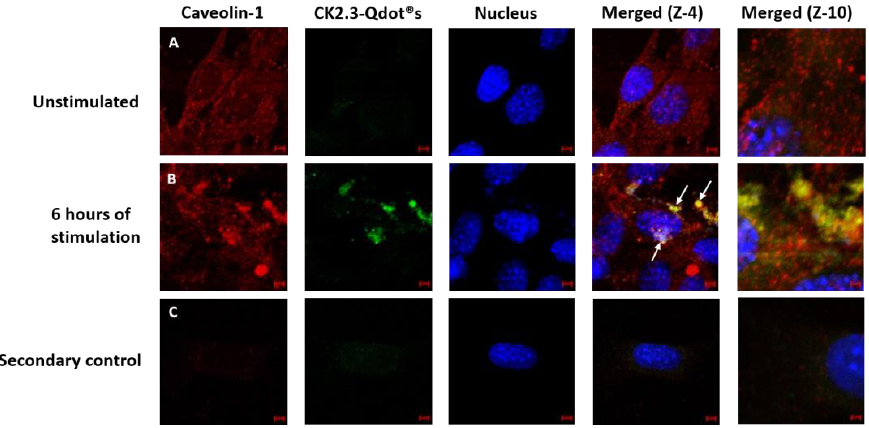
Figure 10. Mechanism of internalization of CK2.3-Qdot® s. ( A ): C2C12 cells were either left untreated or ( B ): treated with 100 nM of CK2.3-Qdot® s for 6 h. Later the cells were fixed and the nucleus (blue) was stained using Hoechst. In case of caveolae, Caveolain-1 (red) and CK2.3-Qdot®s (green) co-localize